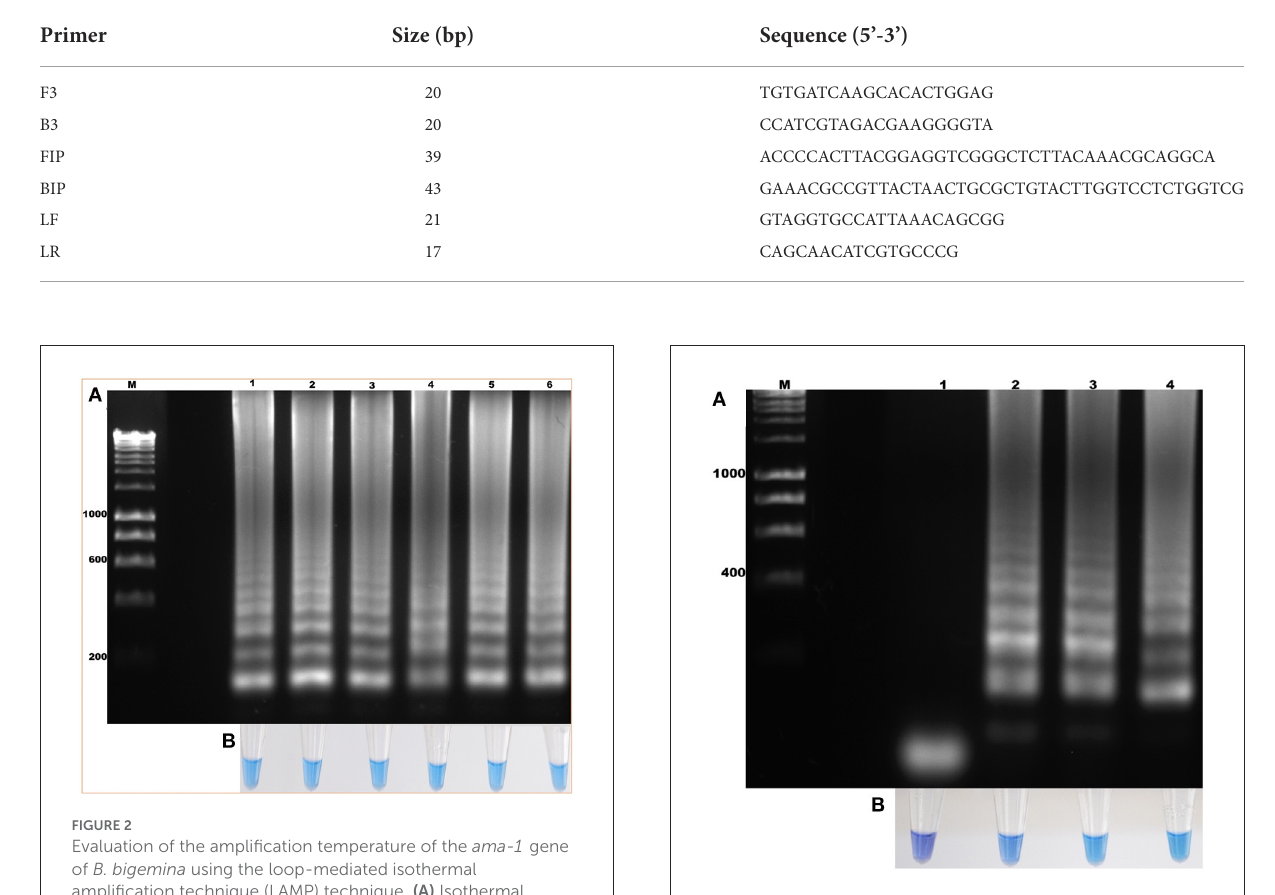
FIGURE3 Determination of the incubation time for the amplification of the ama-1 gene of B. bigemina . (A) Electrophoresis analysis of the isothermal amplification of the ama-1 gene, incubated at different times. (B) Colorimetric test with hydroxynaphthol blue. Lanes: M) Molecular size marker in bp, (1) 15min of reaction, (2) 30min of reaction, (3) 45min of reaction, and (4) 60min of